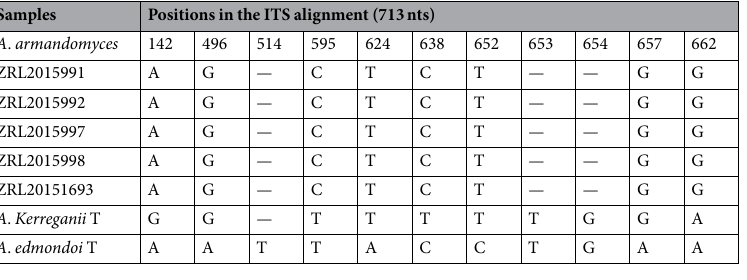
Table 3. ITS nucleotide difference between Agaricus armandomyces and related